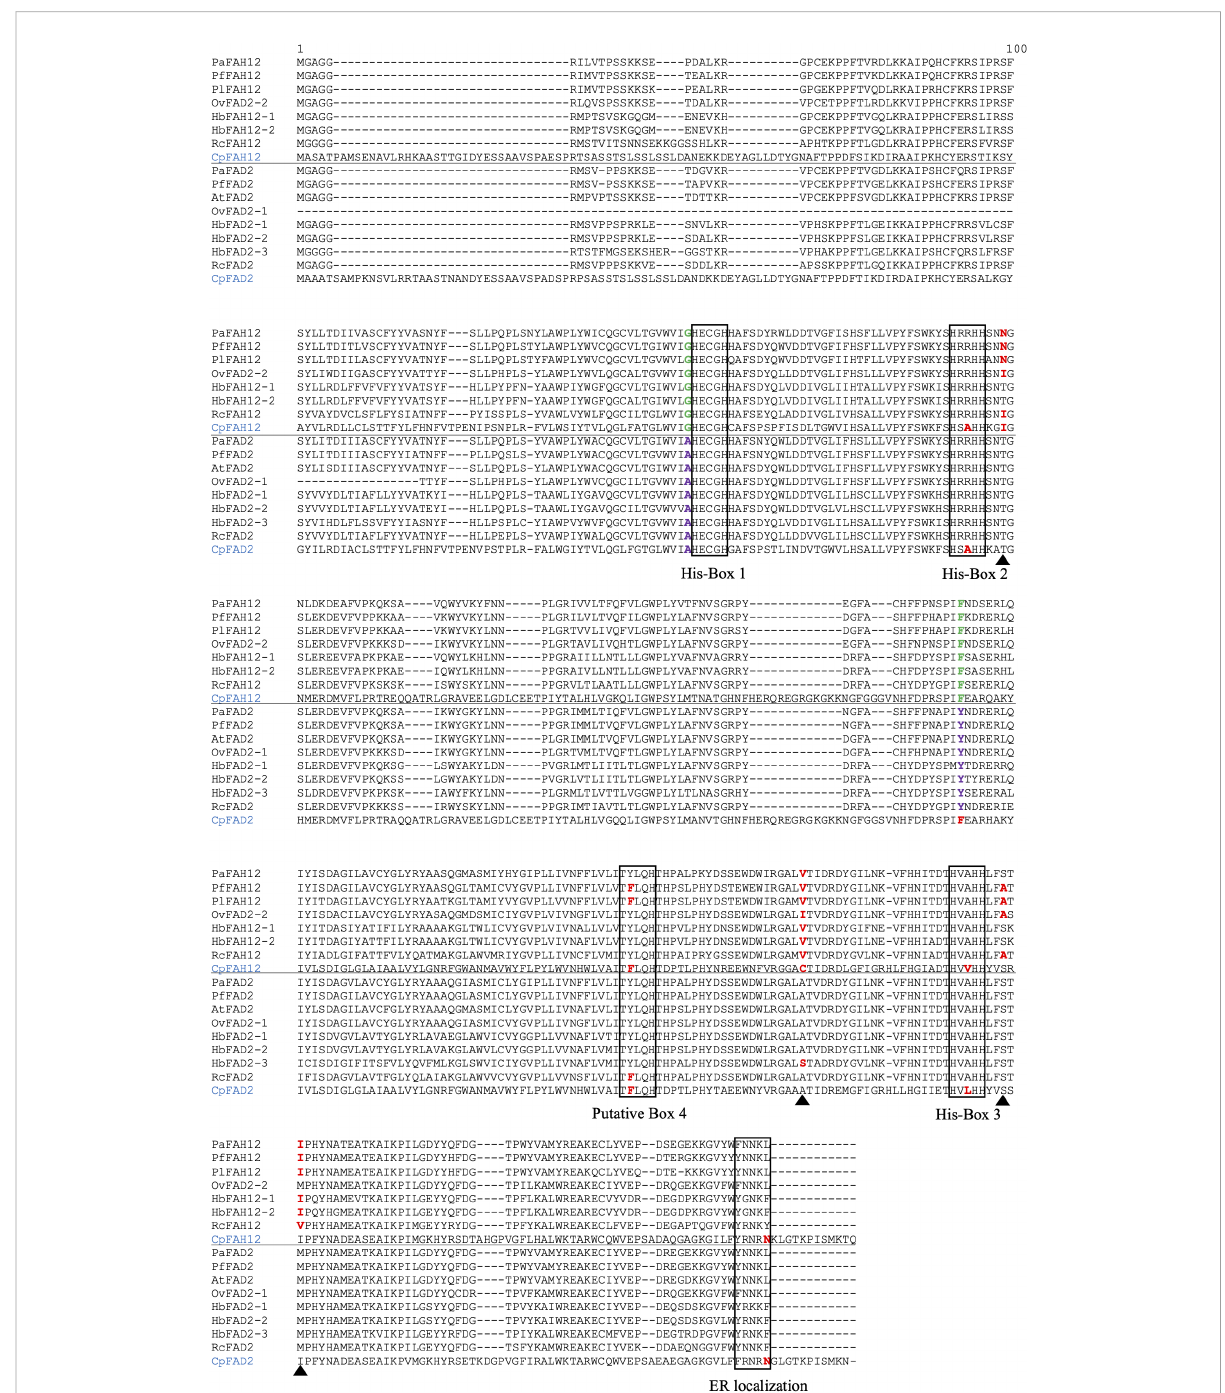
FIGURE 6 Alignment of PaFAH12 and PaFAD2 with other published FAH12s and FAD2s. Species included P. fendleri , P. lindheimeri , A. thaliana , O. violaceus , H. benghalensis , R. communis and fungus C. purpurea . Please note, OvFAD2-2 is characterized as a hydroxylase (Li et al., 2018). The putative box 4 is hypothesized by Robin et al. (Robin et al., 2019). The ER localization signal motif ( F ‐ X ‐ X ‐ K/R/D/E ‐ F ) is proposed by McCartney et al. (McCartney et al., 2004), with the exceptions of fungus CpFAH12 and CpFAD2, where the C ‐ terminal F is a hydrophilic amino acid (Asn) but not a hydrophobic amino acid. The unconsensus residues within sequence of interest were red-bolded. The residues that were strictly conserved in each type of enzyme (A105 and Y218 in all FAD2s, except in fungus CpFAD2) were green and purple-bolded. The four essential residues (T148N, A296V, S322A, M324I) that converted AtFAD2 into a hydroxylase (Broun et al., 1998b) were labeled with black triangles. Sequences used in this alignment: PfFAH12 (AAC32755), PlFAH12 (ABQ01458), OvFAD2-2 (APQ40636), HbFAH12-1